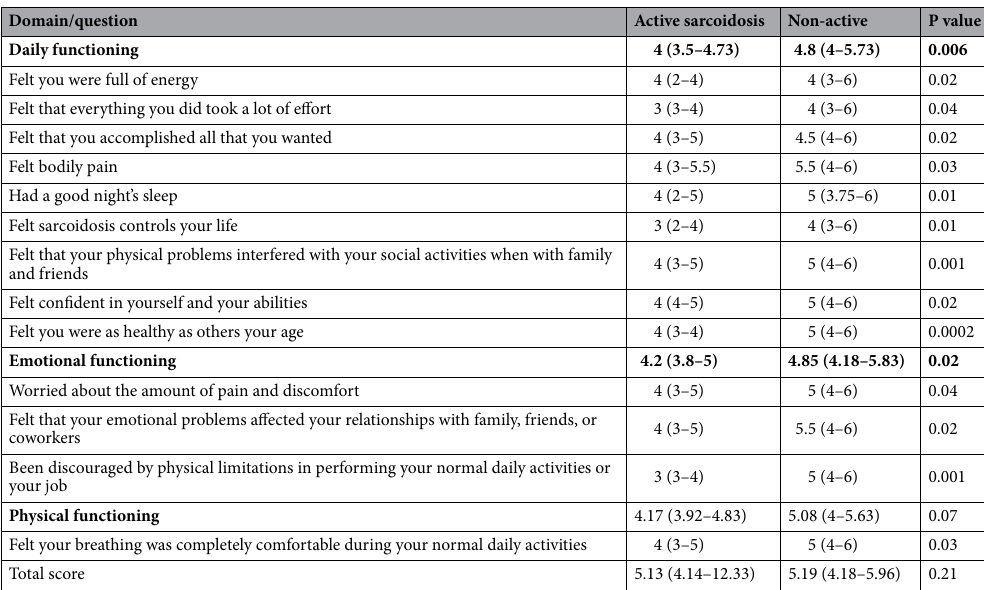
Table 3. Differences between active and non-active sarcoidosis. Data are presented as median (IQR). Presented P values are for Wilcoxon rank sum test.